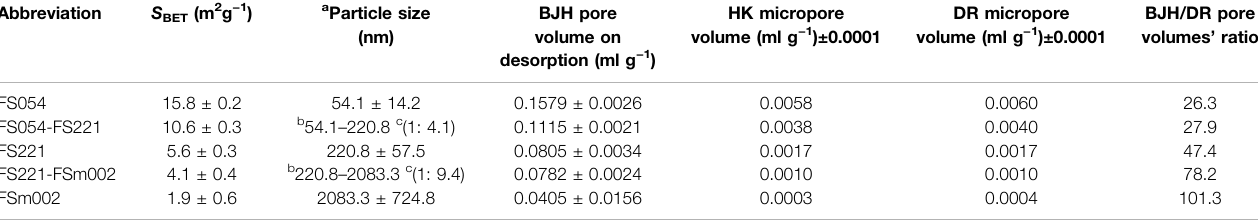
TABLE 1 | Surface area, particle size, pore volume of α -Fe 2 O 3 spherical-like powders with different sizes.